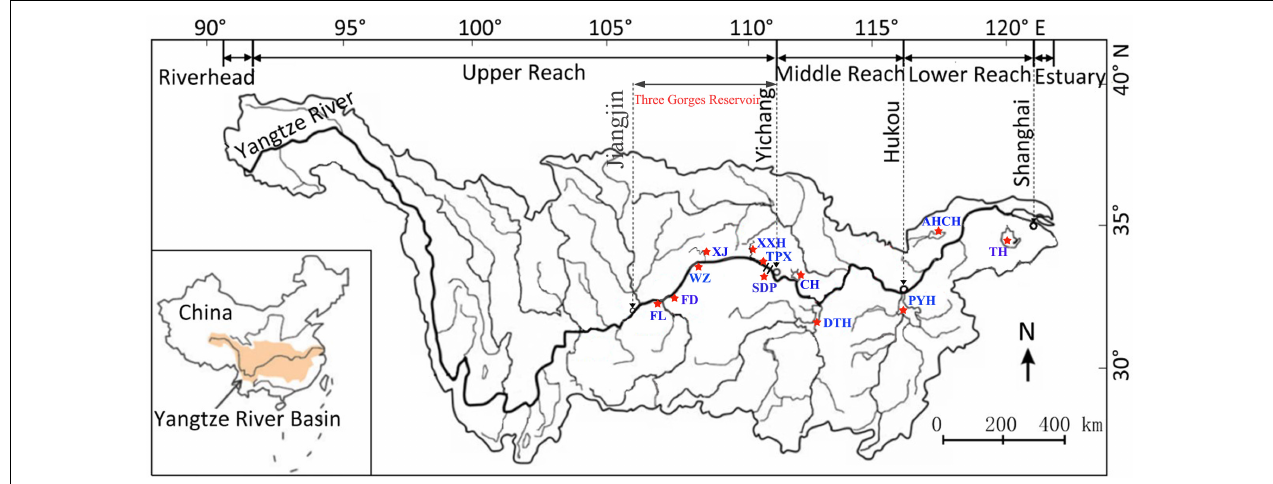
FIGURE 1 | The 12 sampling sites of C. brachygnathus in the Yangtze River Basin. TH, Taihu Lake; AHCH, Chaohu Lake; PYH, Poyanghu Lake; DTH, Dongtinghu Lake; CH, Changhu Lake; SDP, Sandouping; TPX, TaipingXi; XXH, Xiangxi River; XJ, Xiaojiang River; WZ, Wanzhou; FD, Fengdu; FL,